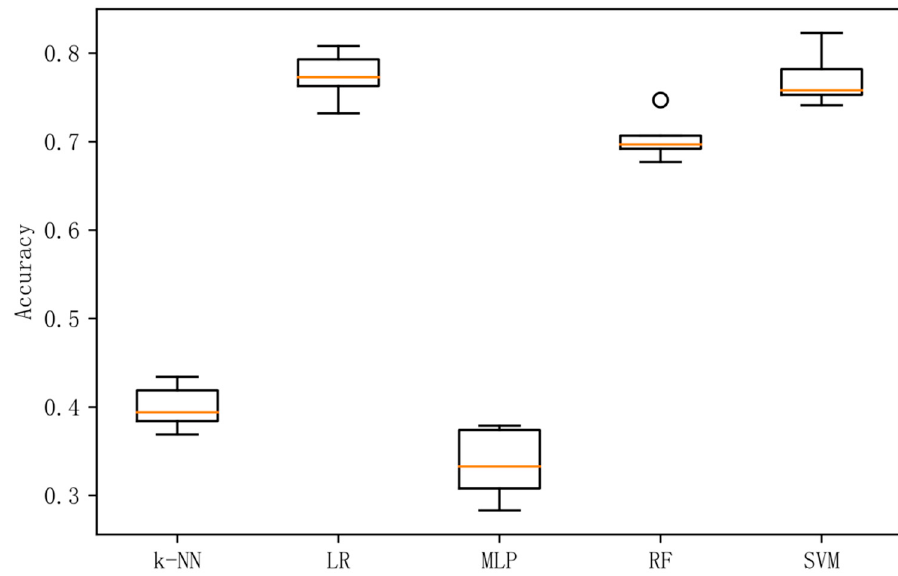
Figure 4. Accuracy in differential entropy dataset with five methods.